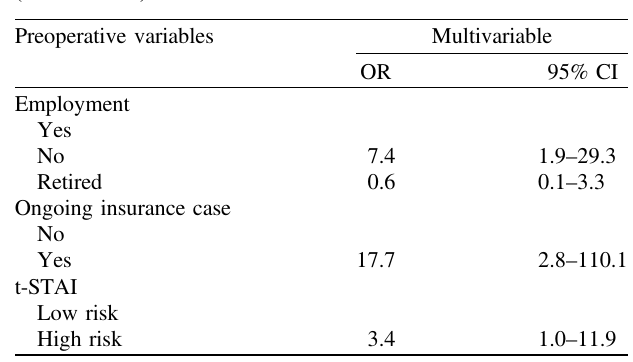
Table 2. Preoperative risk factors for unexplained persistent pain